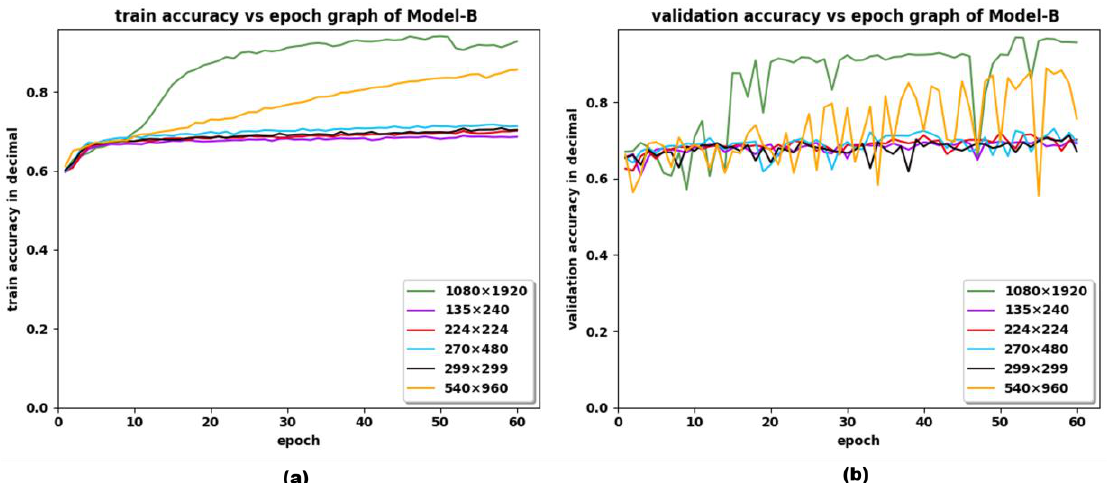
Figure 6. Comparison of ( a ) train and ( b ) validation accuracy versus epoch obtained with various